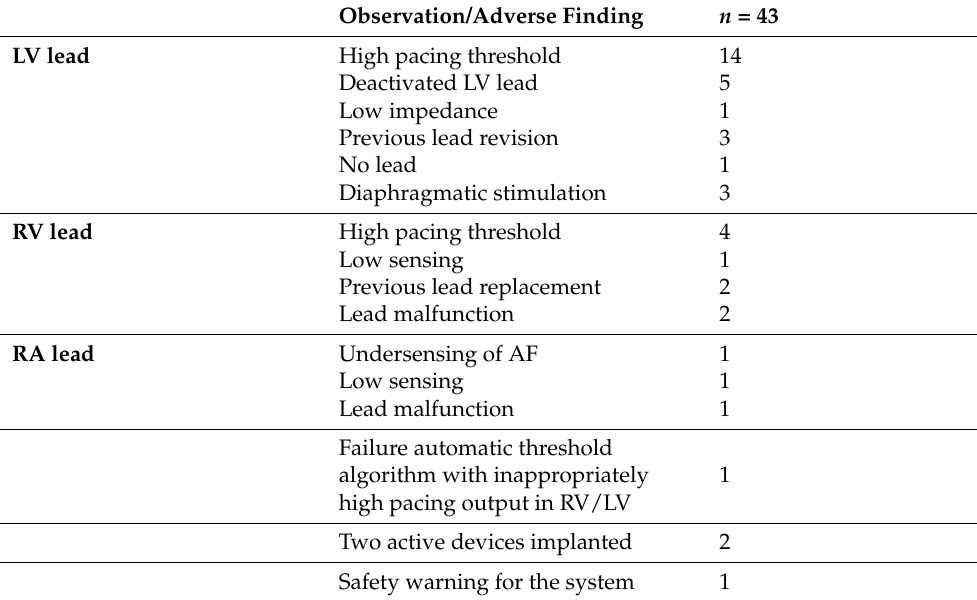
Table 3. Preoperative CRT interrogation. Observations and adverse findings already known from patient’s history or according to the device ID card in 39